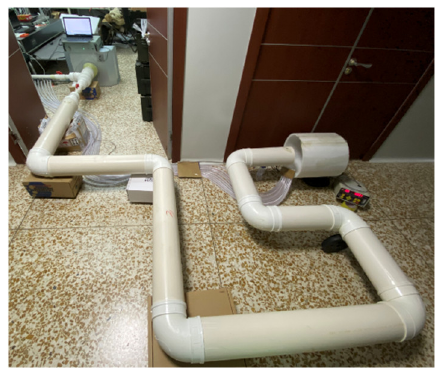
Figure 9. Large-aperture channel sealing experimental model.